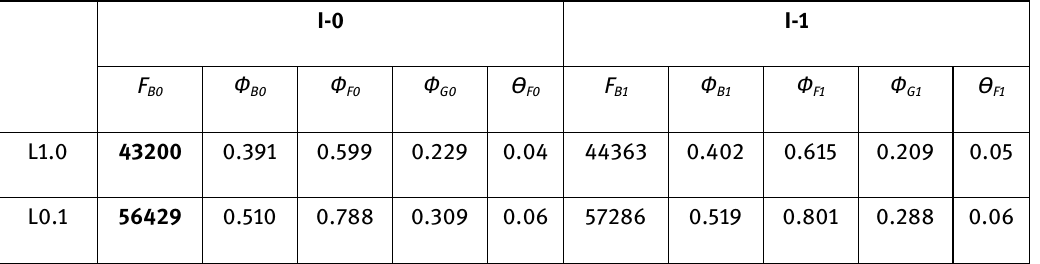
Table 4: The results of numerical calculation of the joint gasketed with FG_1 material